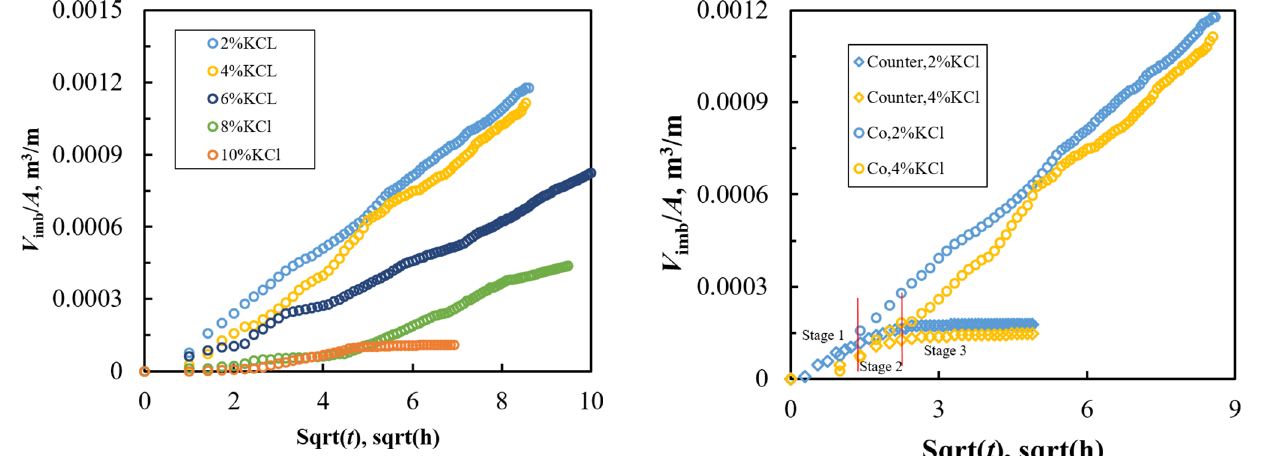
A ) versus square imb / Fig. 4 Imbibition curve with different imbibition directions and KCl concentrations